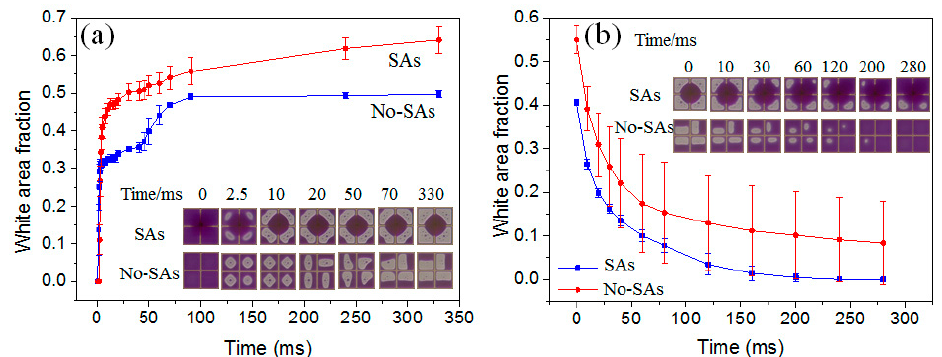
Figure 5. The white area fraction (WA) curve with time for pixels with or without spacer arrays (SAs) at 30 V. The switching process includes the opening process ( a ) and the closing process ( b ). The inserted graphs show the oil–water states at certain time. To show the clear influence of spacer on oil motion, four adjacent pixels are shown in the inserted graphs.